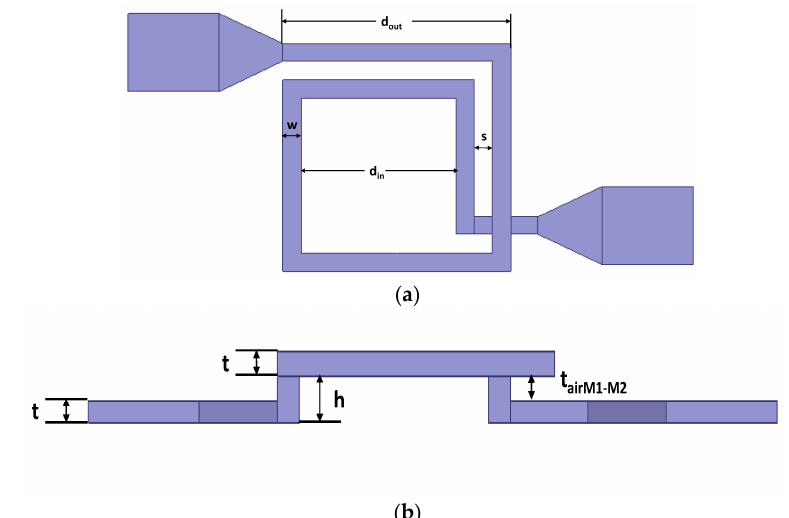
Figure 4. Schematic of the MEMS suspended inductor sample. ( a ) Trimetric view. ( b ) Side view.